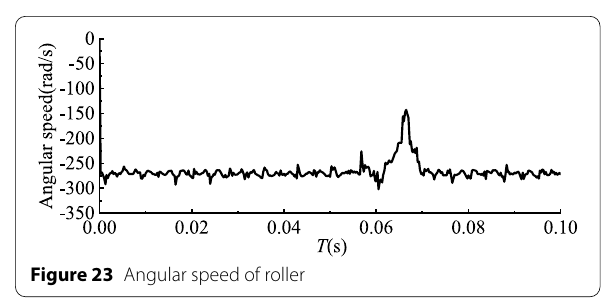
Figure 23 Angular speed of roller